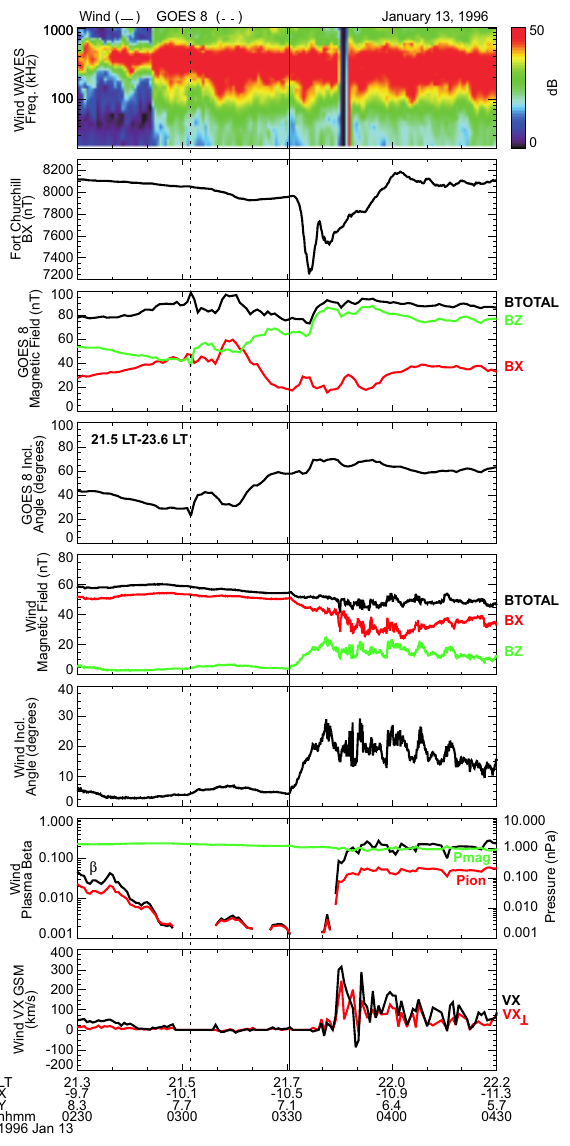
Fig. 2. Wind, CANOPUS and GOES 8 data from 02:30 to 04:30 UT on 13 January 1996. From top to bottom, Fig. 2 shows the Wind WAVES RAD1 receiver data, the X (northward) component of the magnetic field measured at Fort Churchill, the total magnetic field (black) measured by GOES 8, the B x (red) and B z (green) compo- nents of the magnetic field measured by GOES 8, the magnetic field inclination at GOES 8, the total magnetic field (black) measured by Wind, the B x (red) and B z (green) components of the magnetic field measured by Wind, the magnetic field inclination at Wind, the Wind plasma beta (black), the Wind ion (red) and magnetic (green) pressures, and the X component of the flow velocity at Wind. The component of V x perpendicular to the magnetic field is shown in red and the total V x is shown in black. An isolated dipolarization event was observed by the Wind spacecraft starting at 03:30:43 and is marked by the solid black line. The start of the dipolarization ob- served by GOES 8 is marked by a dotted line. GOES 8 was located between 21.5 LT to 23.6 LT for the time period shown in the